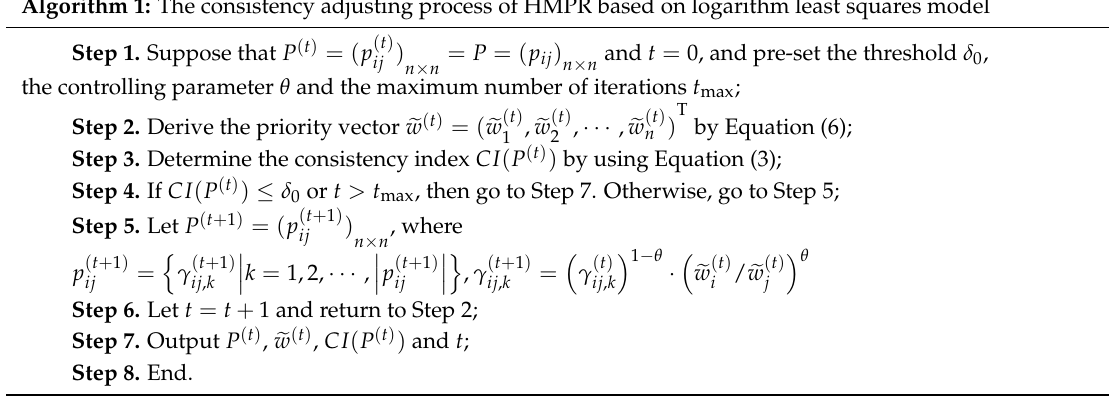
Algorithm 1: The consistency adjusting process of HMPR based on logarithm least squares